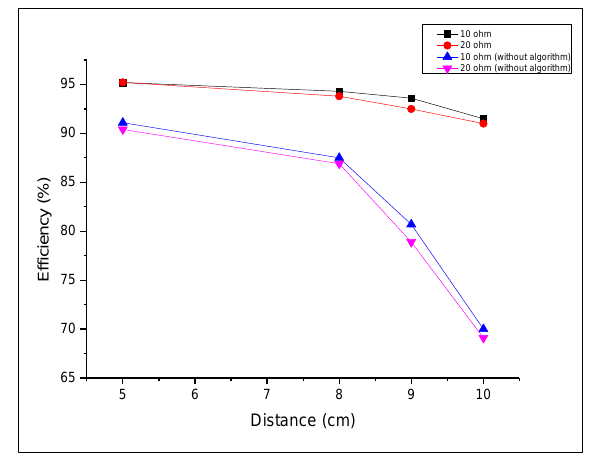
Figure 19. Efficiency of the WPT system with proposed algorithm. Figure 19. E ffi ciency of the WPT system with proposed